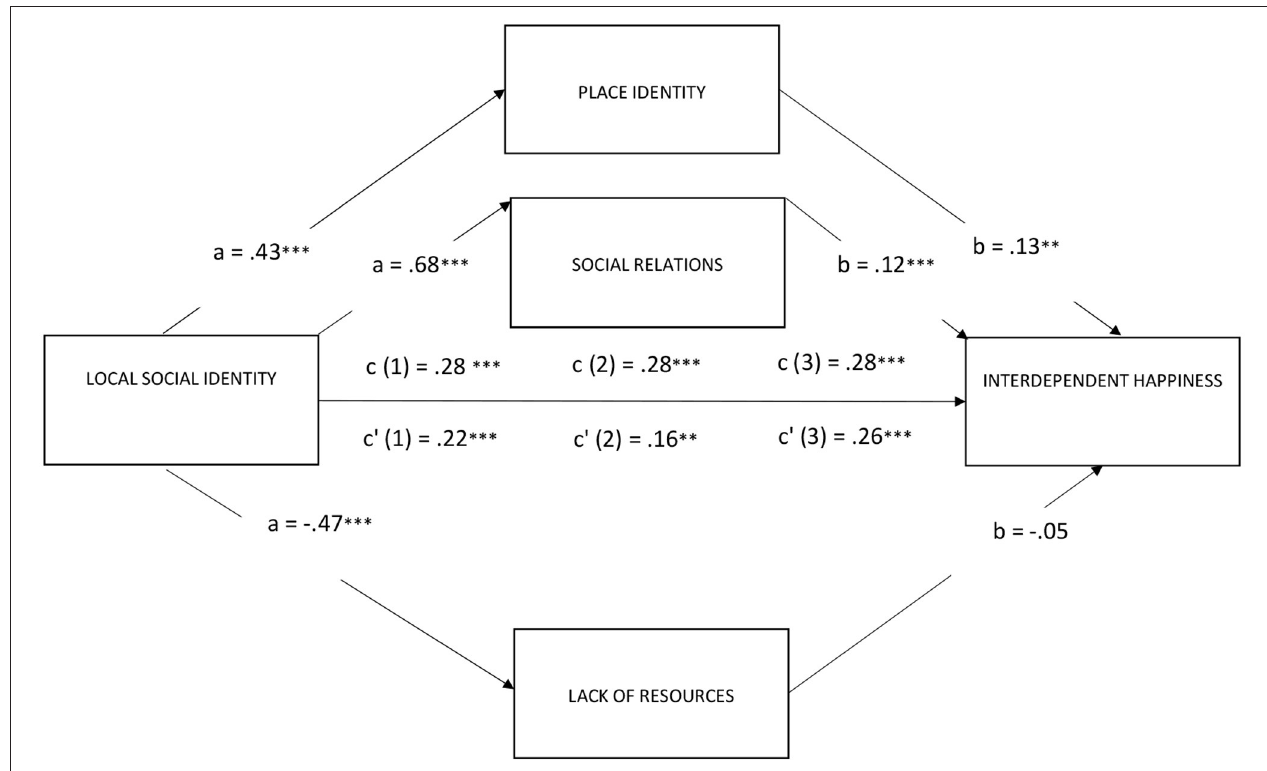
FIGURE 2 | Place identity and social relations mediate the effect of local social identity on interdependent happiness (** p < 0.001; ** p < 0.01; * p < 0.05).